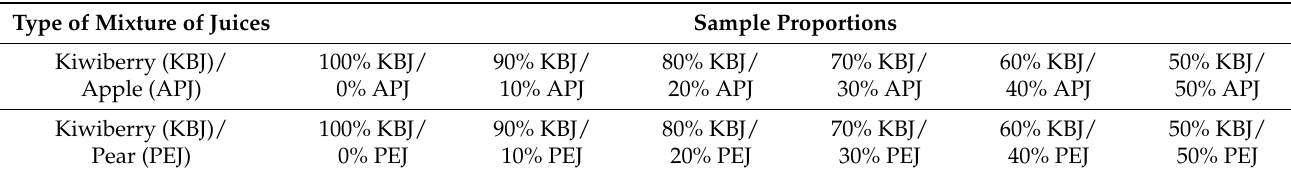
Table 1. The type and proportion of juices used in the experiment. Type of Mixture of Juices Sample